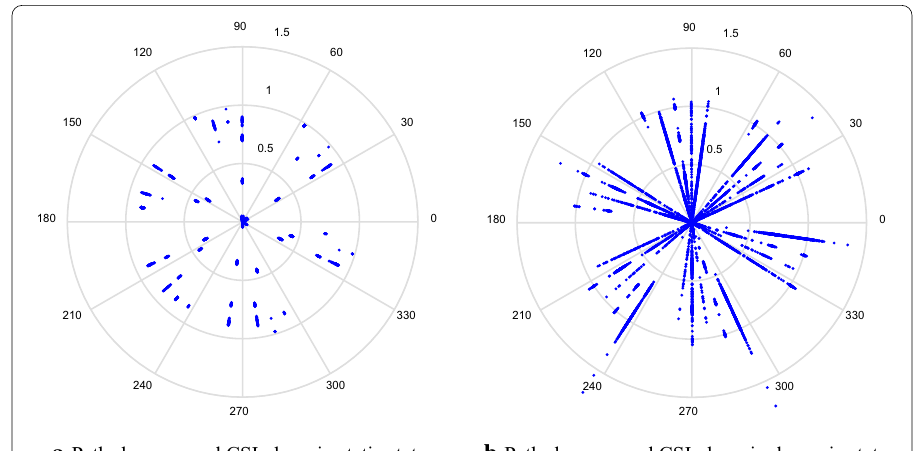
Fig. 5 Path-decomposed CSI phase